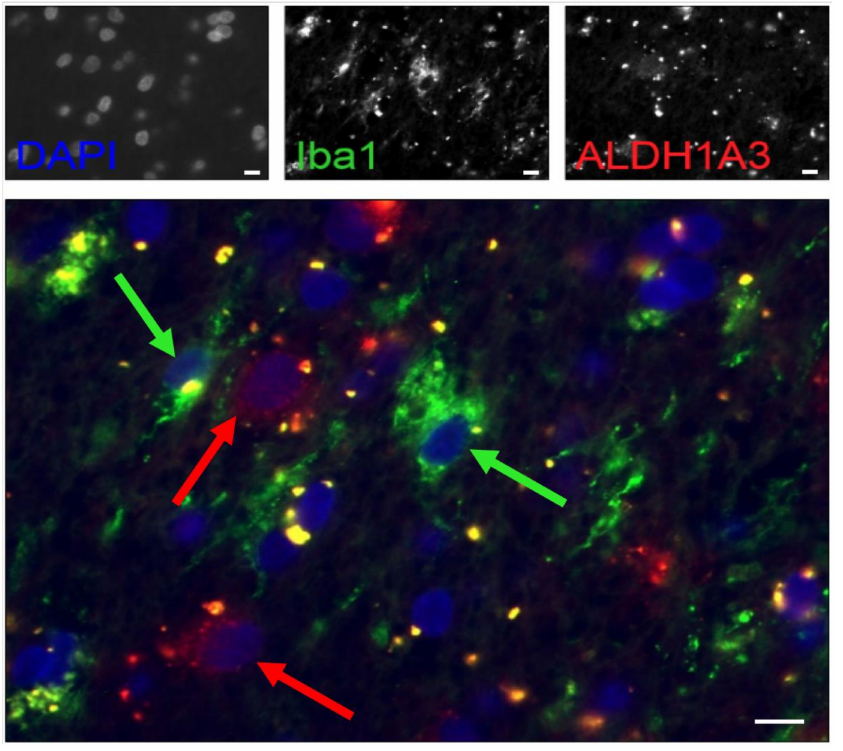
Figure 1. Iba1 and ALDH1A3 immunofluorescence double staining. The picture shows that most cells do not exhibit a co-expression of Iba1 and ALDH1A3. Green arrows mark Iba1-positive microglial cells that lack red signal for ALDH1A3. Red arrows point to ALDH1A3-positive cells without green signal for Iba1. Scale bars: 10 µ